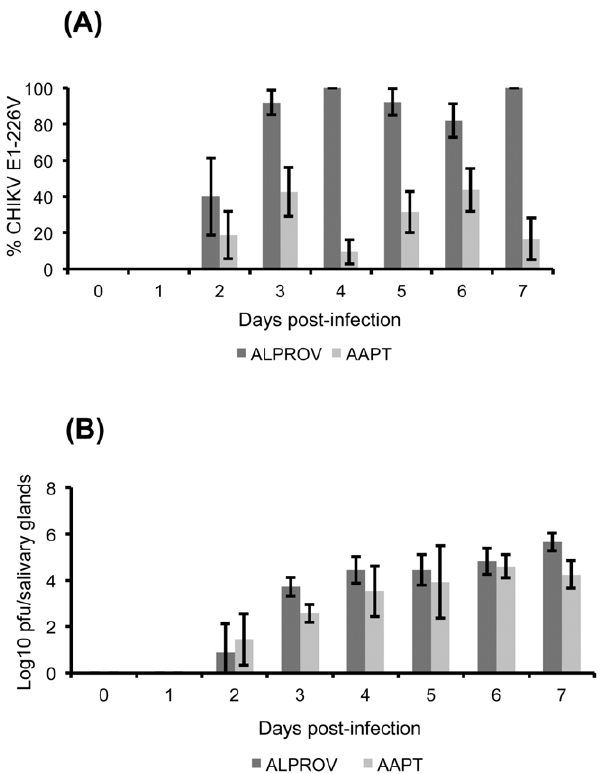
Figure 4. Effect of E1-A226V substitution on CHIKV dissemi- nation to salivary glands of Ae. aegypti (AAPT) and Ae. albopictus (ALPROV). Ae.aegypti (light-grey) and Ae.albopictus (dark-grey) were orally infected with a blood-meal containing both E1-226A and E1-226V provided at the same titer, 10 6.5 pfu/mL. Every day, 5 mosquitoes were sacrificed to isolate salivary glands. The proportion of E1-226V compared to E1-226A (A) and the number of infectious particles (B) were determined. Error bars show the confidence intervals (95%) for % CHIKV E1-226V and the standard deviations for Log10